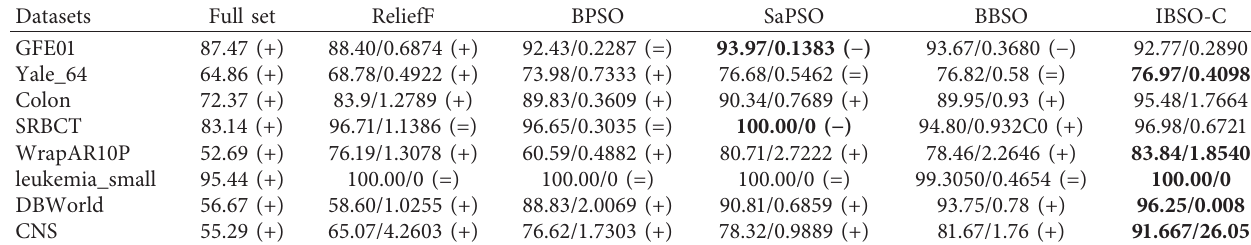
Table 4: AC values obtained by IBSO-C and the four comparison algorithms.